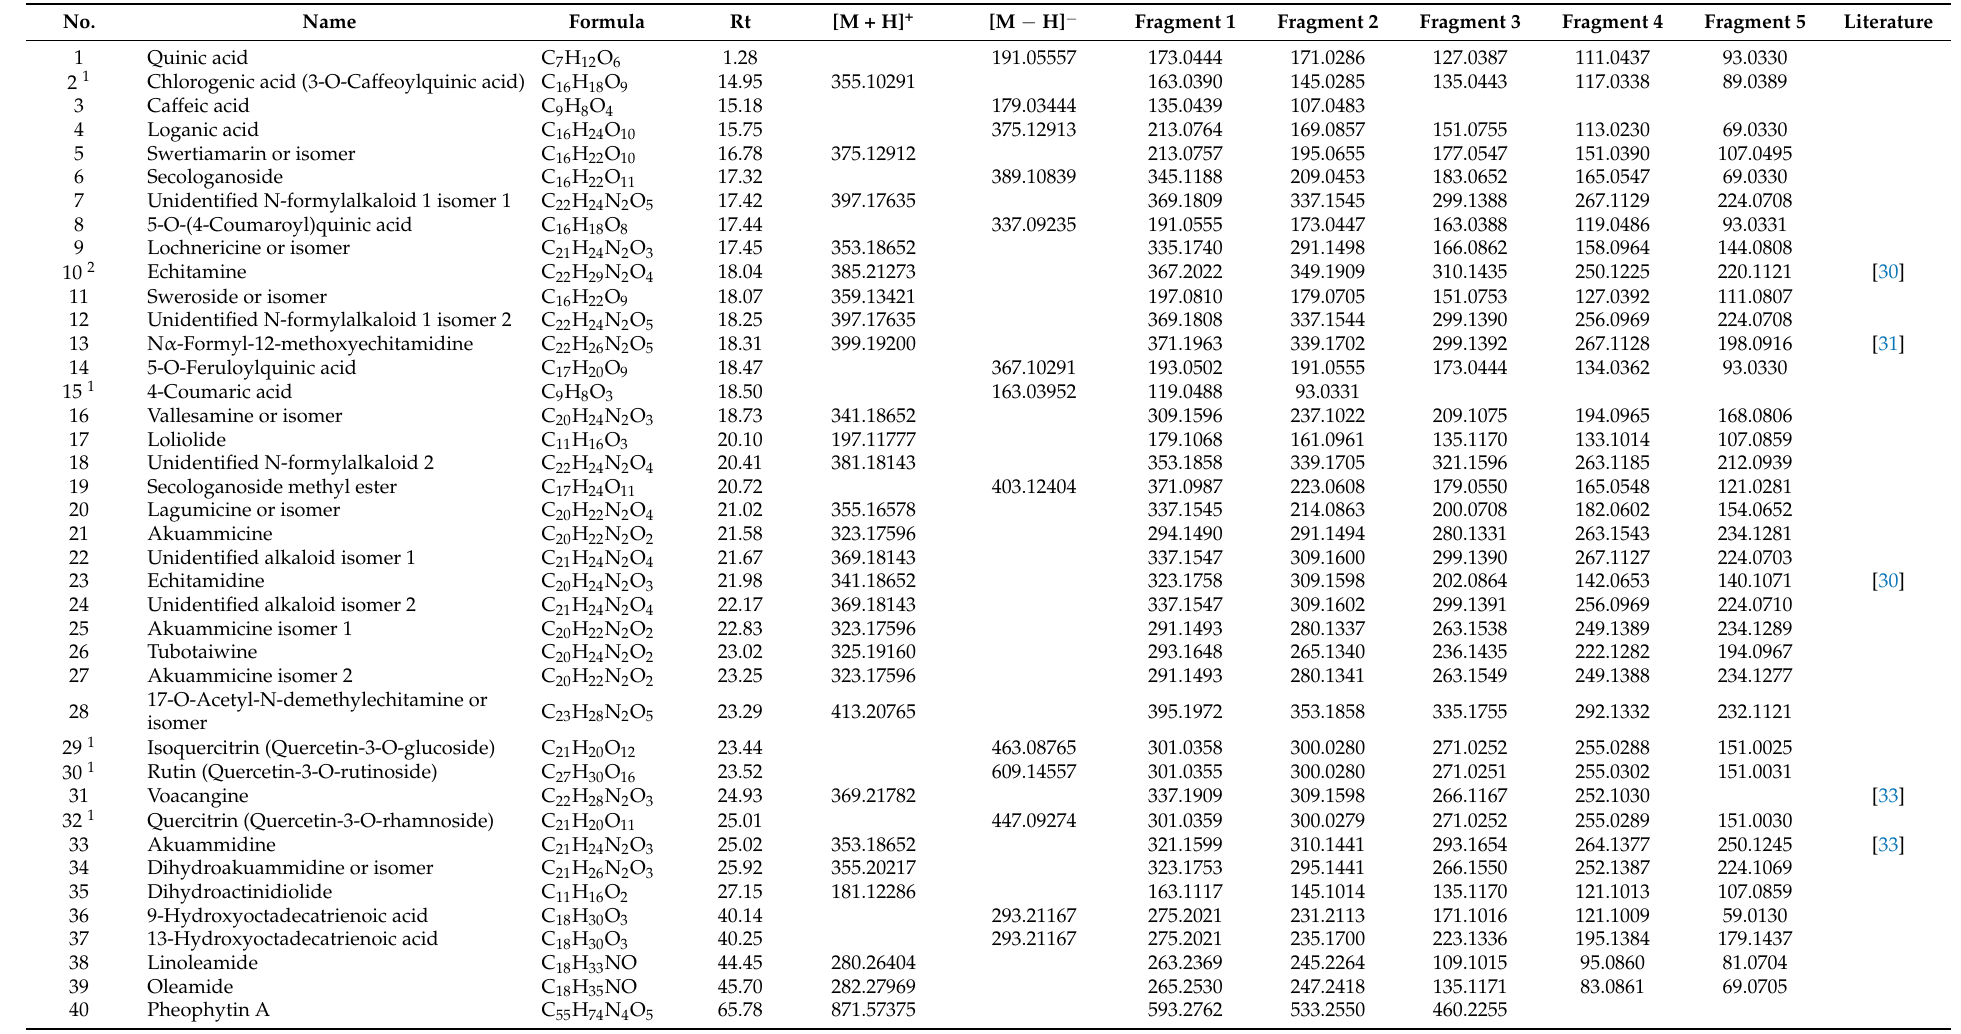
Table 3. Chemical characterization of leaves—MAC-EA (not